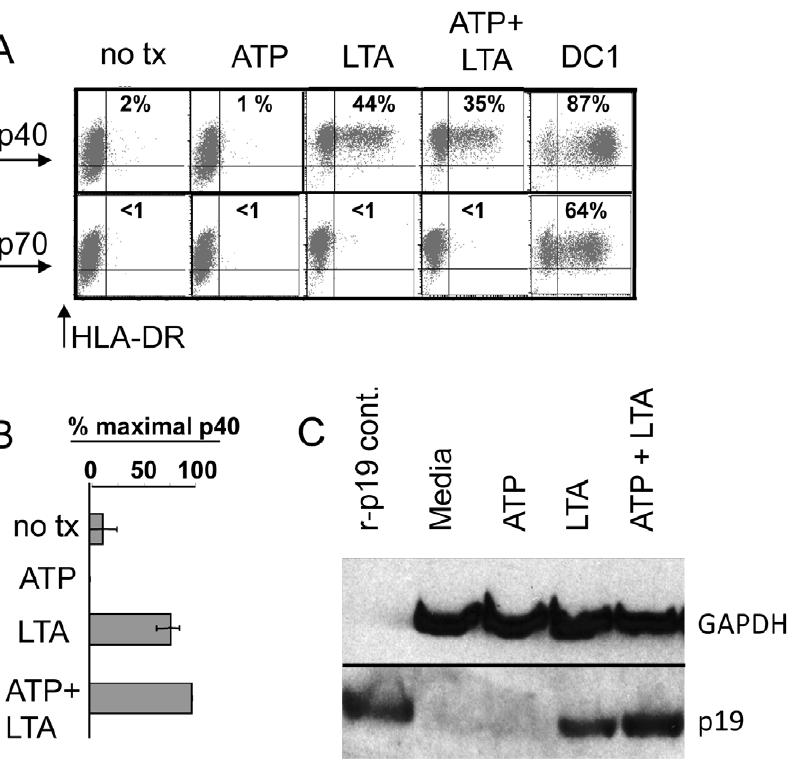
Figure 5. Synergistic up-regulation of IL-23 is regulated through production of p19 but not the p40 subunit. (A) Monocytes pre-treated with ATP were stimulated with LTA for 4 h prior to addition of Brefeldin A. After 24 h further incubation, harvested cells were surface-stained with FITC-labeled anti-HLA-DR, permeablized and intracellular-stained with PE-labeled anti- IL-12 p70 or anti IL-12/23 p40 and subjected to FACS analysis. Percentiles in each panel denote proportion of double-positive cells. (B) Duplicate culture supernatants from cells not receiving Brefeldin A were analyzed for IL-12/23 p40 secretion by ELISA. Results shown are mean percent maximum values from 4 donors + / 2 SEM. (C) Western blot analysis of whole cell extracts probed with anti-IL-23 p19 antibody, or GAPDH as loading control. Results representative of 2